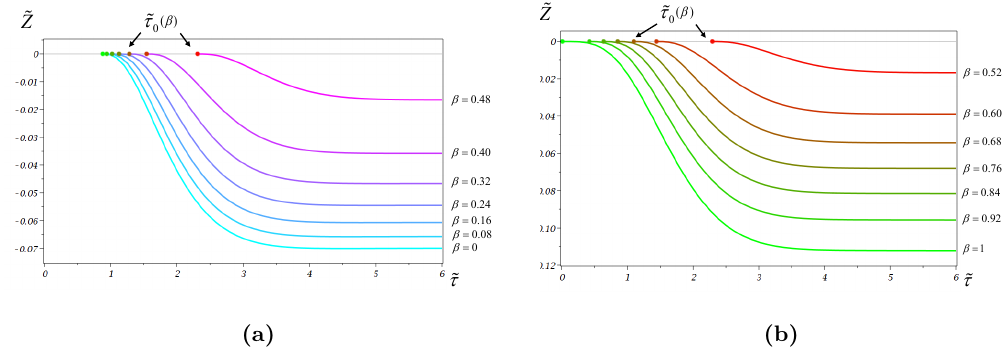
˜ ˜ Figure 3. (a) Z (˜ τ ) for the case k = +1 , (b) Z (˜ τ ) for the case k = − 1 , and various values of β . This relation implies that the right-hand side of the equation for Z 0 (6.16) is always